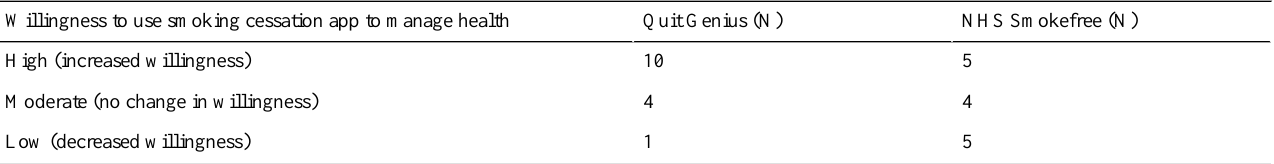
Table 3. Numbers of users whose willingness to use a smoking cessation app to manage their health was high, moderate, or low, for each app. NHS: National Health Service.